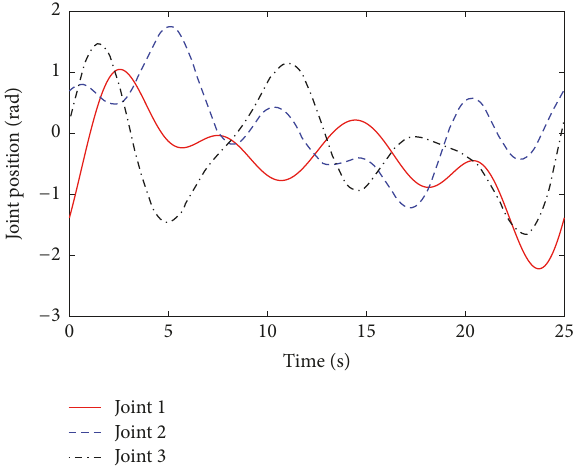
Figure 3: Optimized exciting trajectories in joint